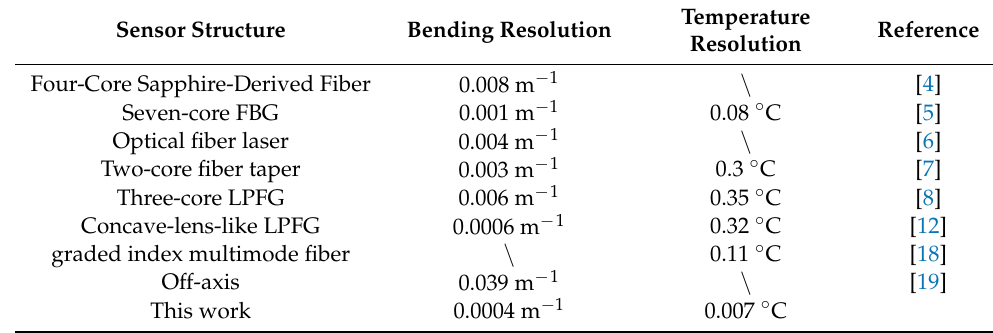
Table 4. Resolution comparison between different types of sensors. Sensor